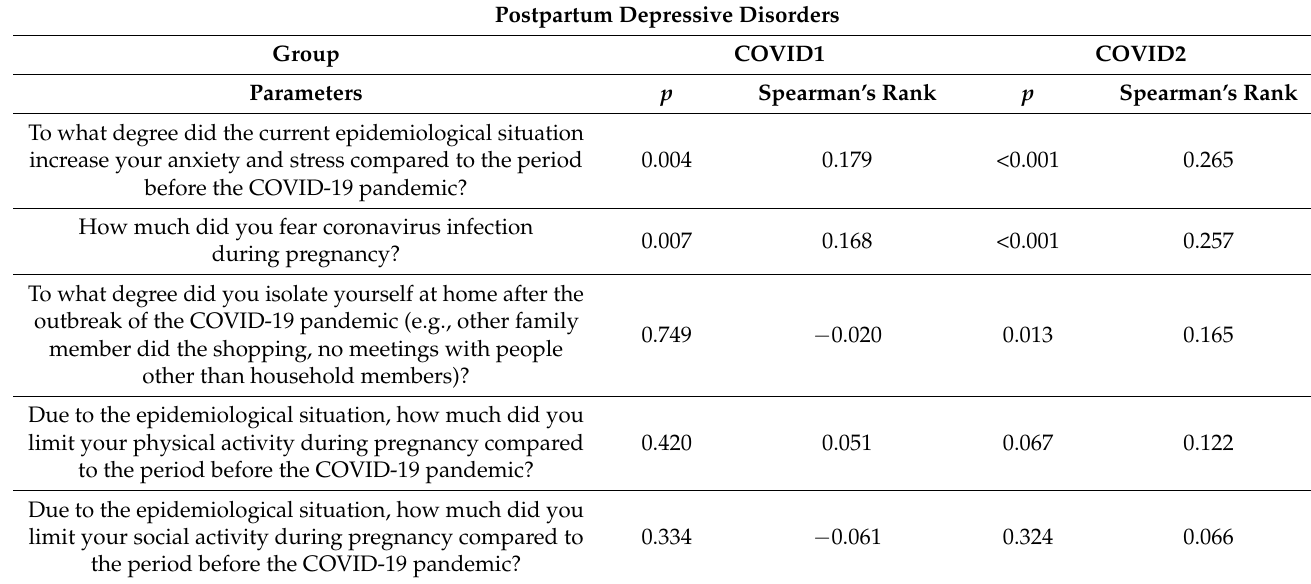
Table A5. Changes in lifestyle and psychophysical status and the risk of developing depressive disorders in women giving birth during the